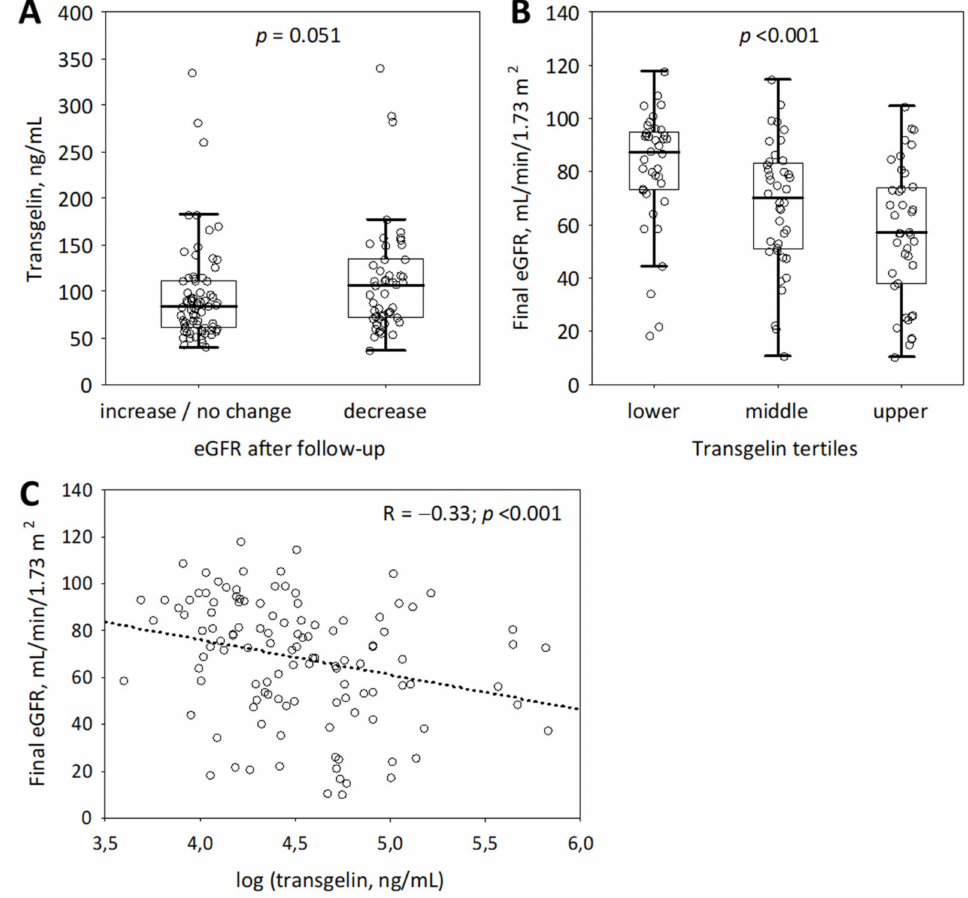
Figure 2. Associations between baseline serum transgelin and final eGFR (CKD-EPI Cr ) values in the group of 126 patients with MM: baseline transgelin by eGFR changes (no change or decrease versus increase during the observation period; ( A ); final eGFR values by transgelin tertiles (the tertiles’ boundaries were 71.0 and 110.6 ng/mL; ( B ) and the correlation between baseline transgelin and final eGFR ( C ). Data on panels ( A , B ) are shown as median (central line), interquartile range (box), non-outlier range (whiskers); circles represent raw data. CKD-EPI Cr , Chronic Kidney Disease Epi- demiology Collaboration equation based on serum creatinine; eGFR, estimated glomerular filtration rate; MM, multiple